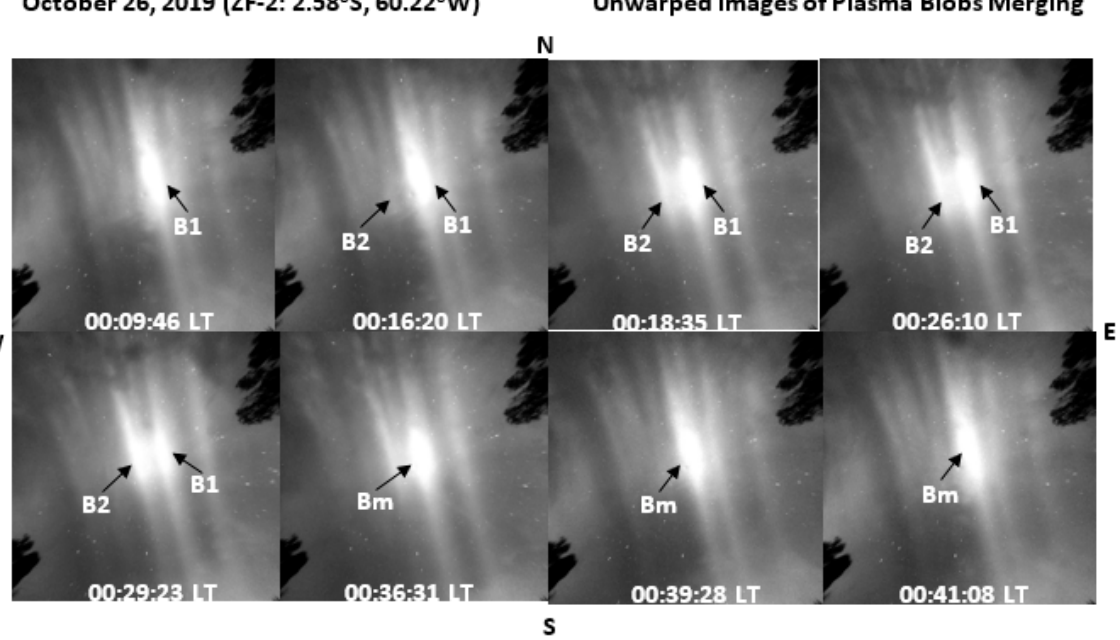
Figure 5. Sequential unwarped images of plasma blob merging observed at the equatorial region (2.58° S, 60.22° W). The bright regions along the field lines are the plasma blobs. The blobs drift eastward and then later merge. B1 signifies Blob1, B2 signifies Blob2 and Bm signifies Merged Blob.